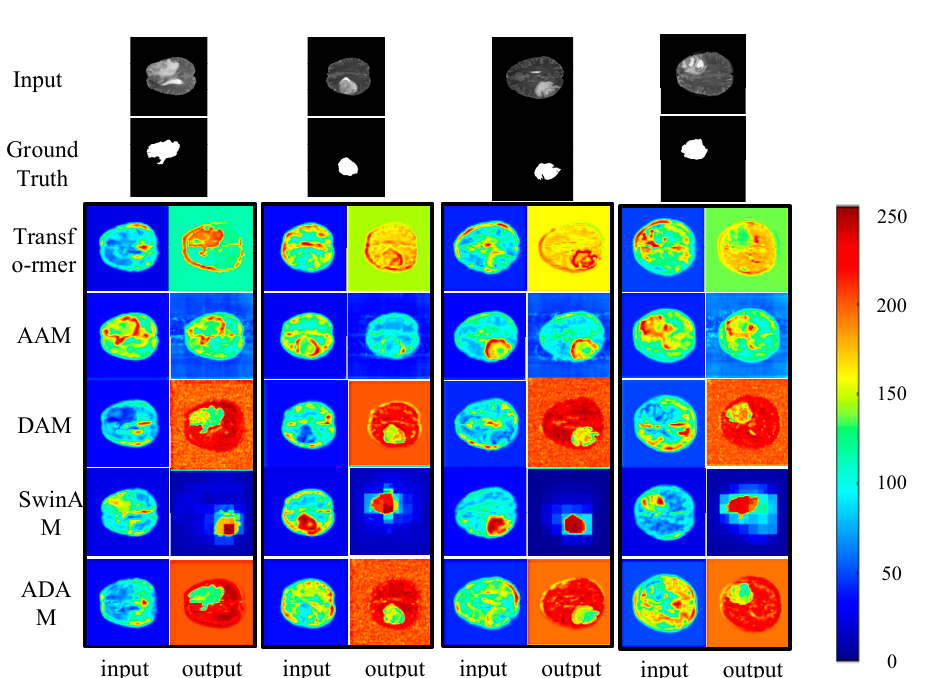
Figure 4. Visualization of input and output of different self-attention modules. Each row presented a raw MRI scan, ground-truth, Transformer heatmaps, AAM heatmaps, DAM heatmaps, SwinAM heatmaps, and ADA module heatmaps, respectively.